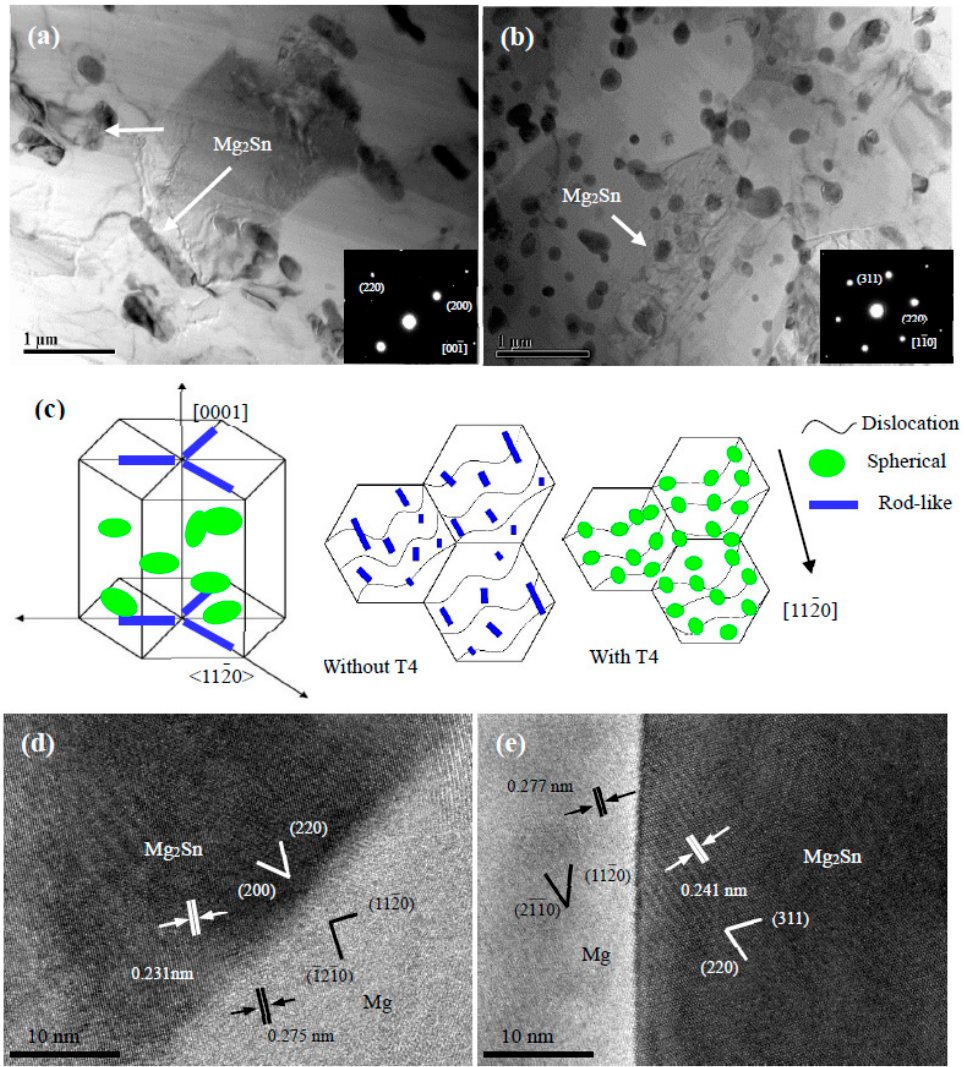
Figure 4. Bright field TEM images of DRXed region of extruded TZA822 alloys taken from the zone axis of [0001] (inset: SAED pattern) ( a ) without T4; ( b ) with T4; ( c ) The schematic illustration of the two different types of precipitates; ( d , e ) HR-TEM of rod-like and spherical